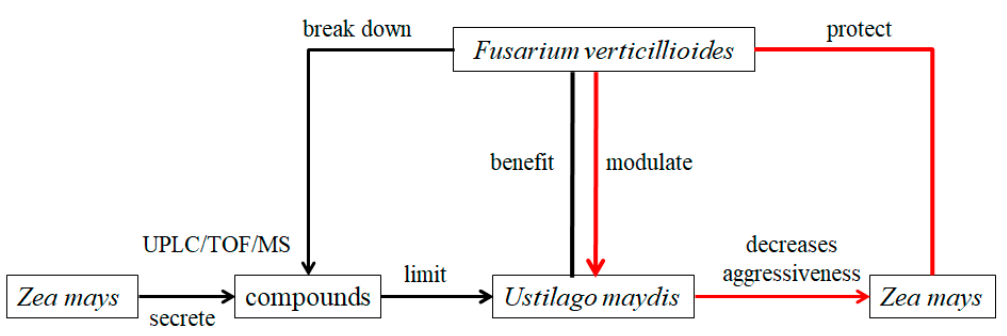
Figure 3. Interactions among Fusarium verticillioides , Ustilago maydis , and Zea mays . Paraconiothyrium variabile , an endophytic fungus from the plant Cephalotaxus harringtonia , can inhibit the growth of common phytopathogens. Thus, P . variabile is considered a beneficial organism to a host. It has been observed that there is a strong antagonistic effect between the endophyte P . variabile and the phytopathogen F . oxysporum , and